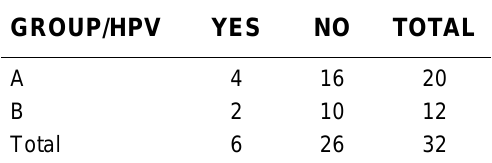
Presence of HPV DNA in Biopsied Fragment of the Vestibular Papillomatosis of Group A and of Group B from the PCR and Statistical Results GROUP/HPV